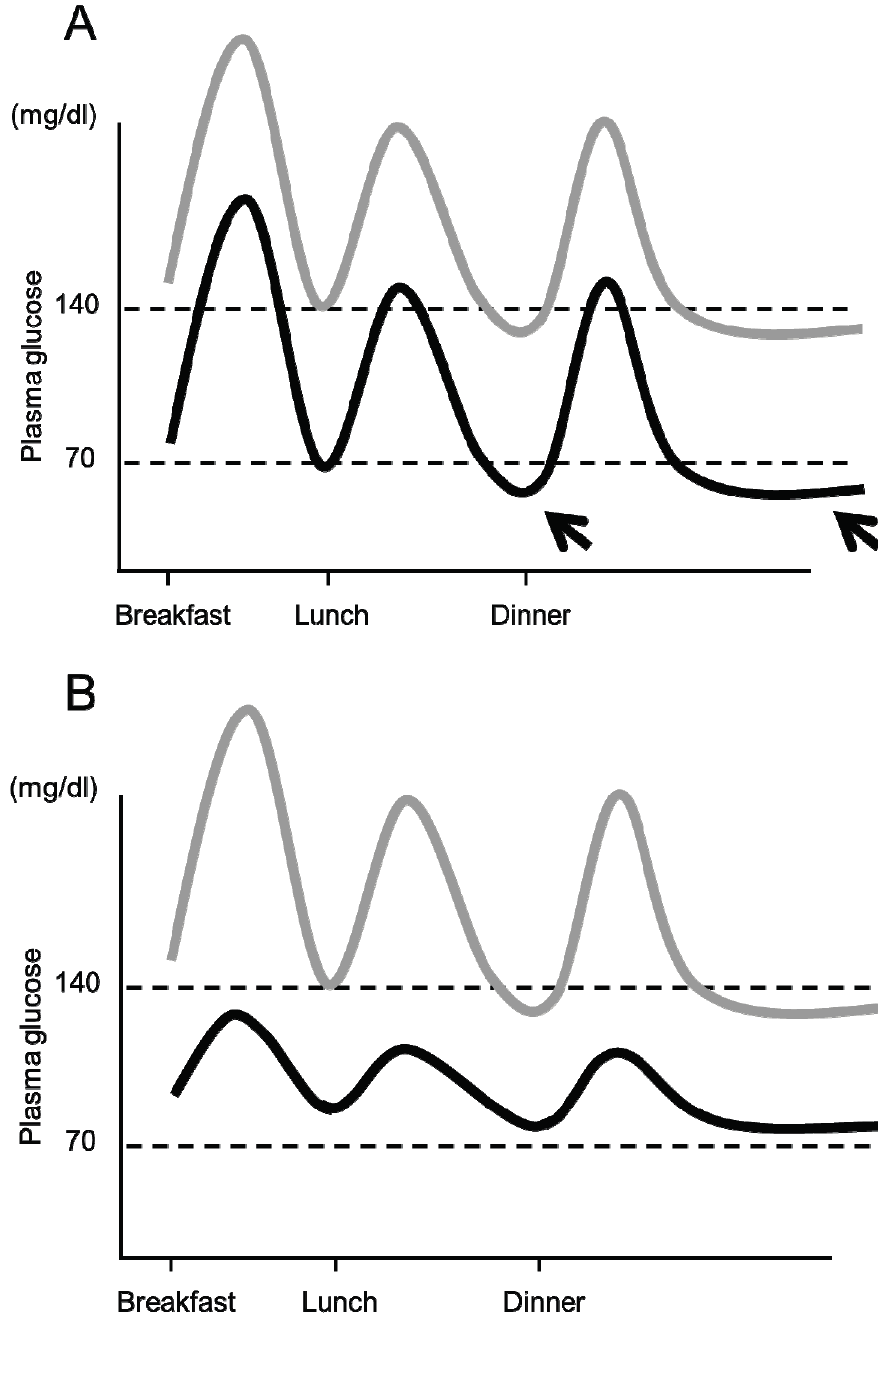
Figure 5. Importance of controlling postprandial glycemic excursion for prevention of hypoglycemia. ( A ) If mean plasma glucose level is lowered without controlling postprandial glycemic excursion (gray line → black line), the risk of pre-meal and nocturnal hypoglycemia increases (arrows); ( B ) Lowering the mean glucose level with correction of postprandial glycemic excursion (gray line → black line) results in a low risk of hypoglycemia. Note that the mean plasma glucose level is similar in both cases, indicating similar HbA1c in both